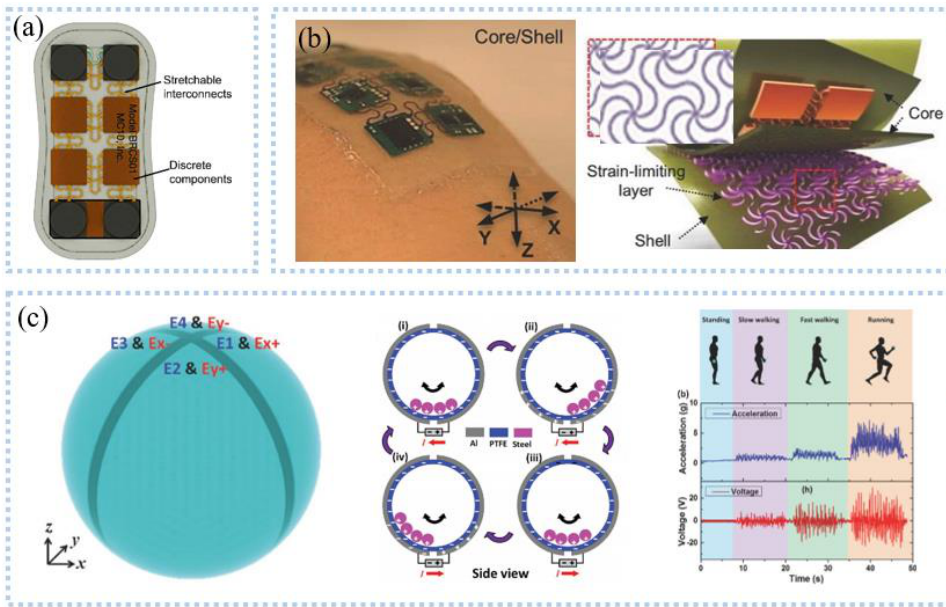
Figure 5. Inertial signal detection: ( a ) bottom view of motion sensing patch. Reprinted with permis- sion from Ref. [71]. Copyright 2020 John Wiley and Sons, ( b ) optical images and an exploded view schematic illustration for a core/shell structure. Reprinted with permission from Ref. [72]. Copyright 2015 John Wiley and Sons, ( c ) schematic diagram showing the T − ball device structure (left), operation mechanism of the T − ball under in − plane vibration along x − axis (middle), and the acceleration level and the output voltage from different type of exercises (right) Reprinted with permission from Ref. [73]. Copyright 2017 John Wiley and Sons.